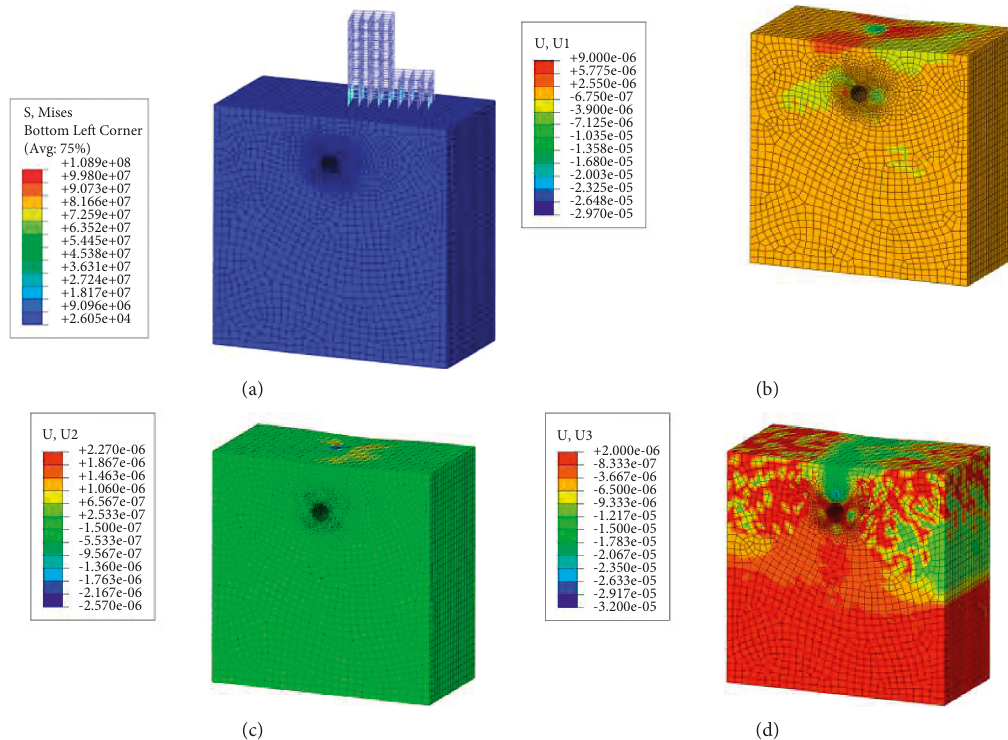
Figure 9: Calculated results of the tunneling model. (a) Stress cloud diagram. (b) x -direction displacement. (c) y -direction displacement. (d) z -direction